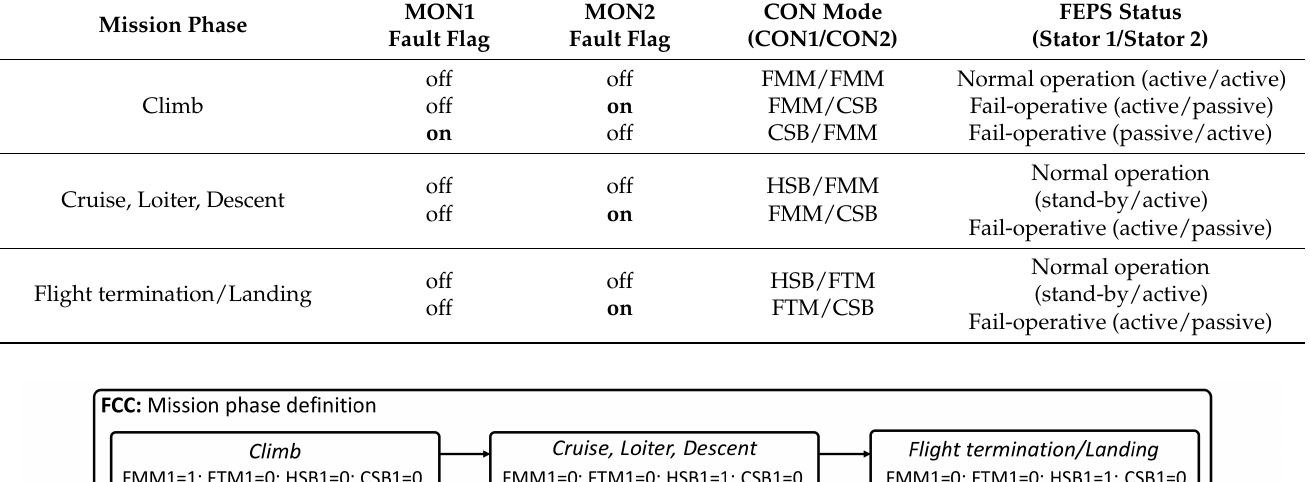
Table 1. FEPS operation modes as functions of mission phases and detected faults.